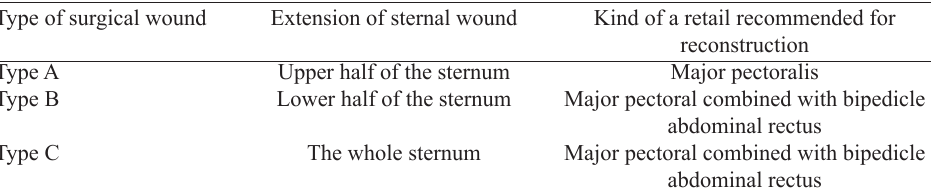
Table 4. Classification proposed by Greig in 2007, considering the regional location of the wound.